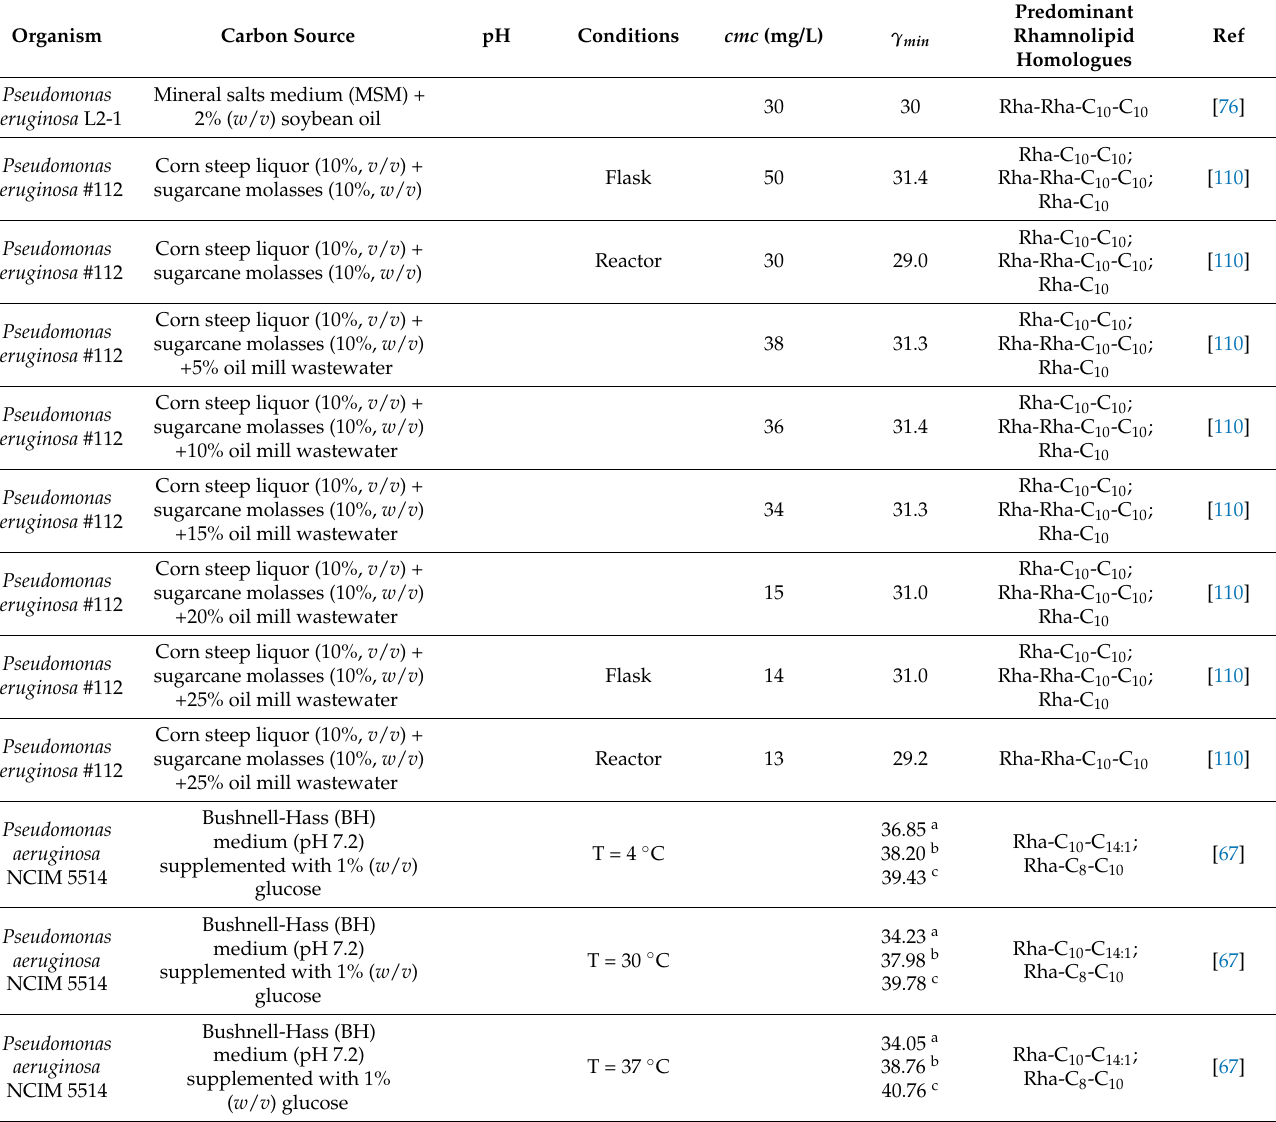
Table 2. The cmc and surface activity of microbial rhamnolipid characterized as crude